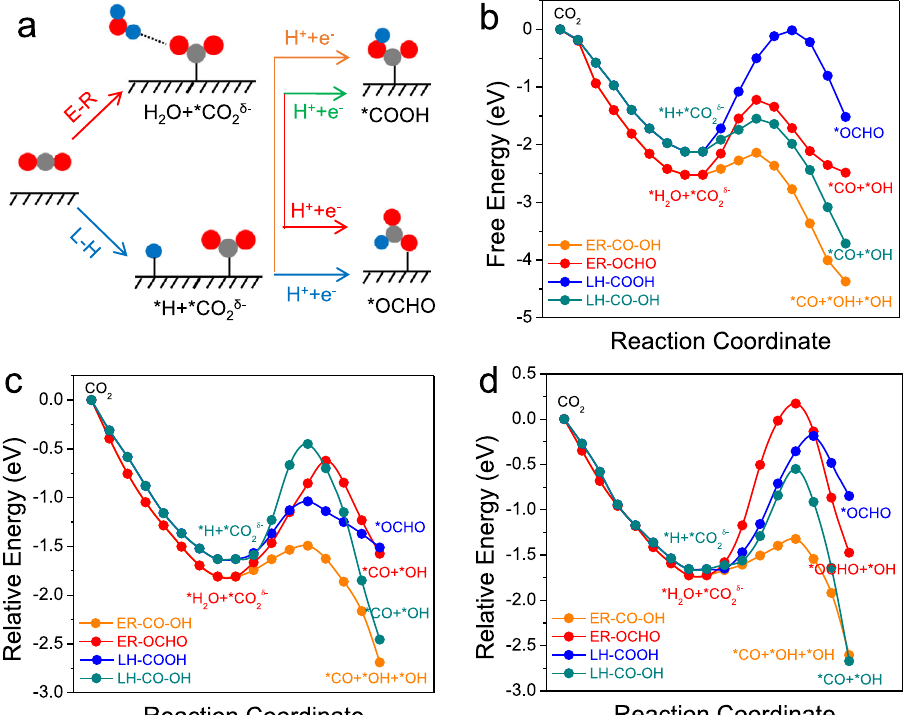
Fig. 4 Selectivity of CO 2 electroreduction. a Schematic diagram of the ER and LH mechanisms of CO 2 electroreduction to *COOH or *OCHO. Kinetic pathways for the electroreduction of CO 2 on the surfaces of ( b ) Mo 2 B 2 , c Ti 2 B 2 , and d Cr 2 B 2